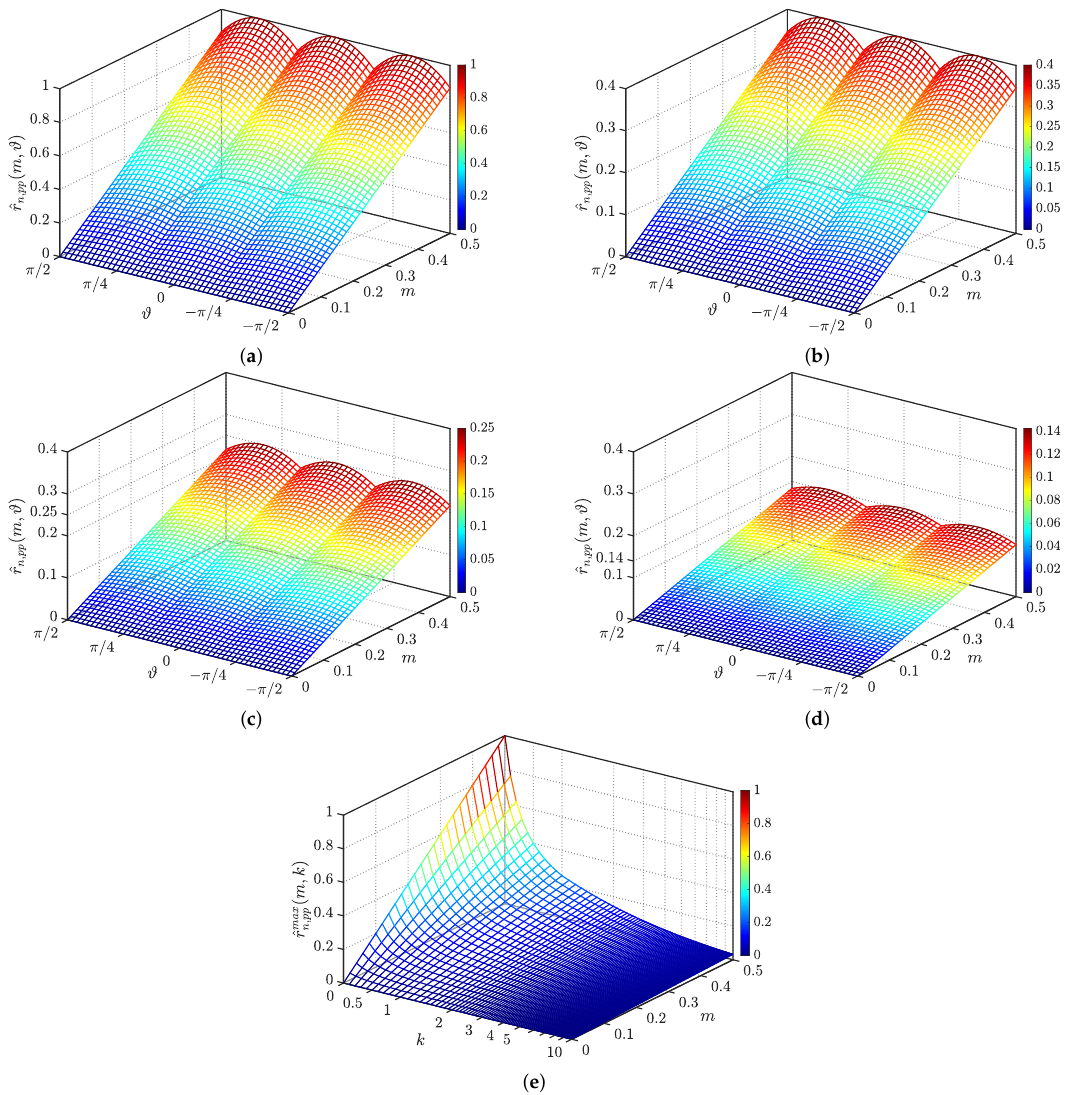
Figure 12. Normalized, peak-to-peak neutral switching current ripple envelopes in case of SPWM ( a ) k = 0, ( b ) k = 0.5, ( c ) k = 1, and ( d ) k = 2 and ( e ) maximum, normalized, peak-to-peak neutral switching current ripple as a function of modulating index m and k factor.